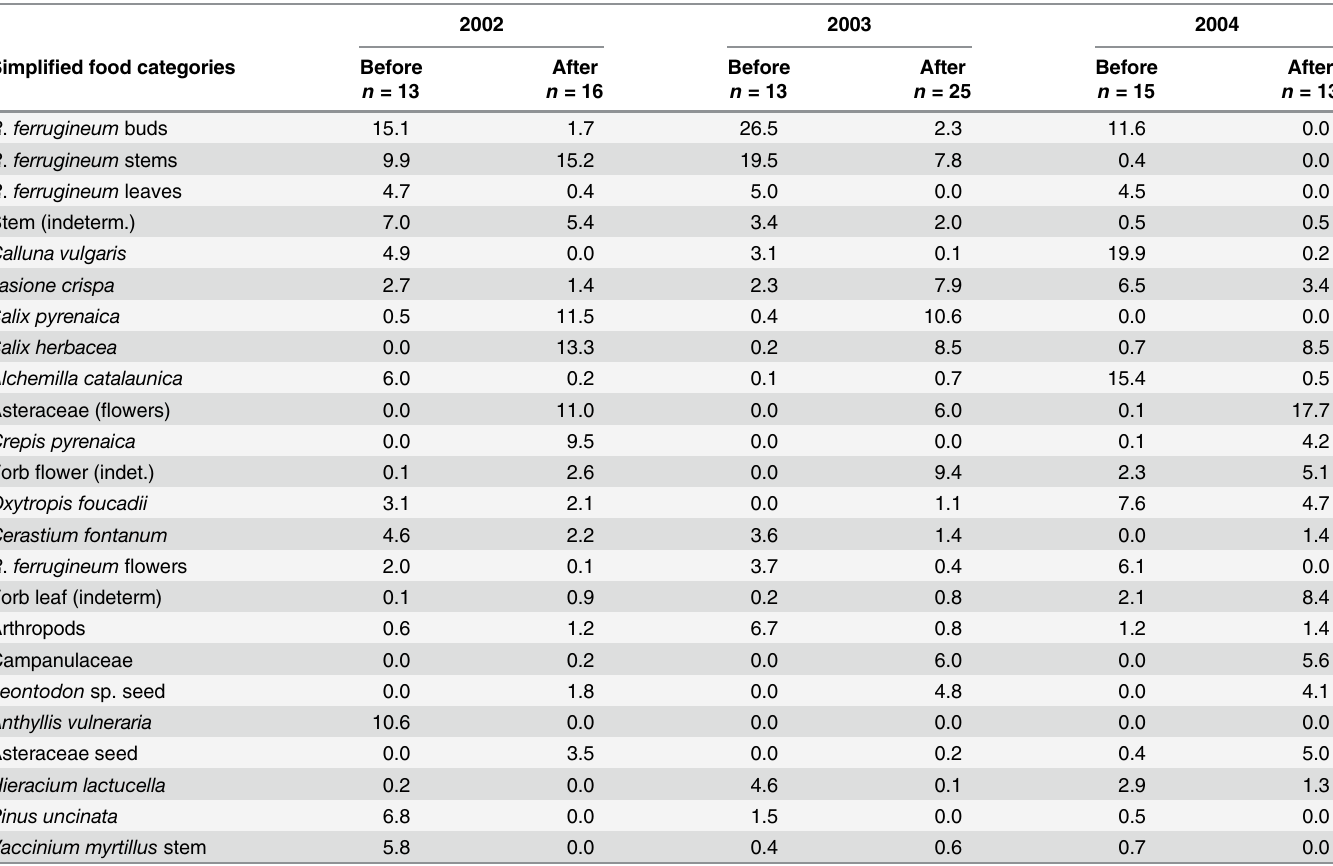
Table 3. Mean values (%) of diet composition of the top 24 diet items (80% of total diet) before snowmelt (from January to the average day of snow- melt) and after snowmelt (from the day of snowmelt to the end of July). 2002 2004 Simpli fi ed food categories